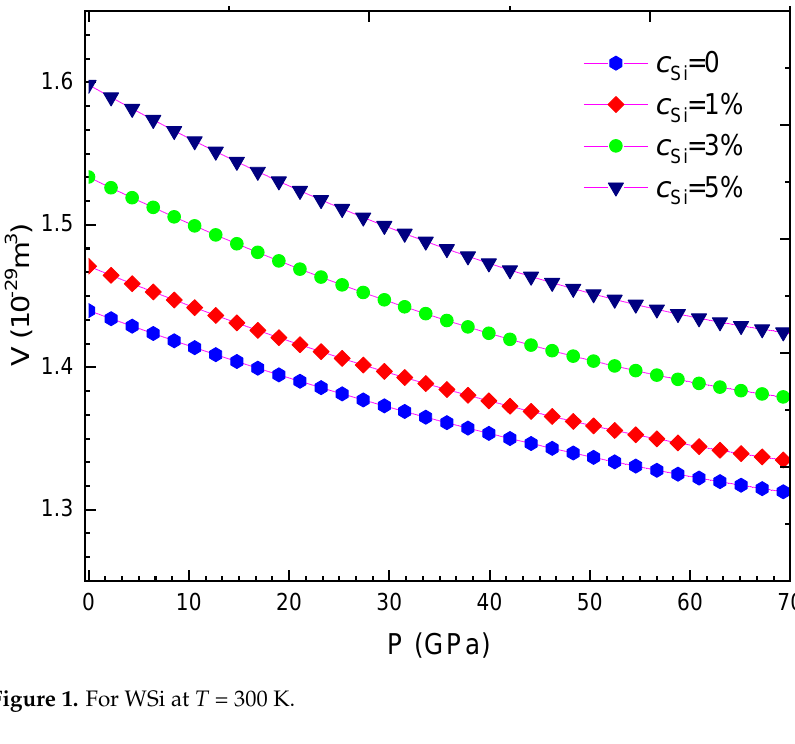
Figure 1. For WSi at T = 300 K.